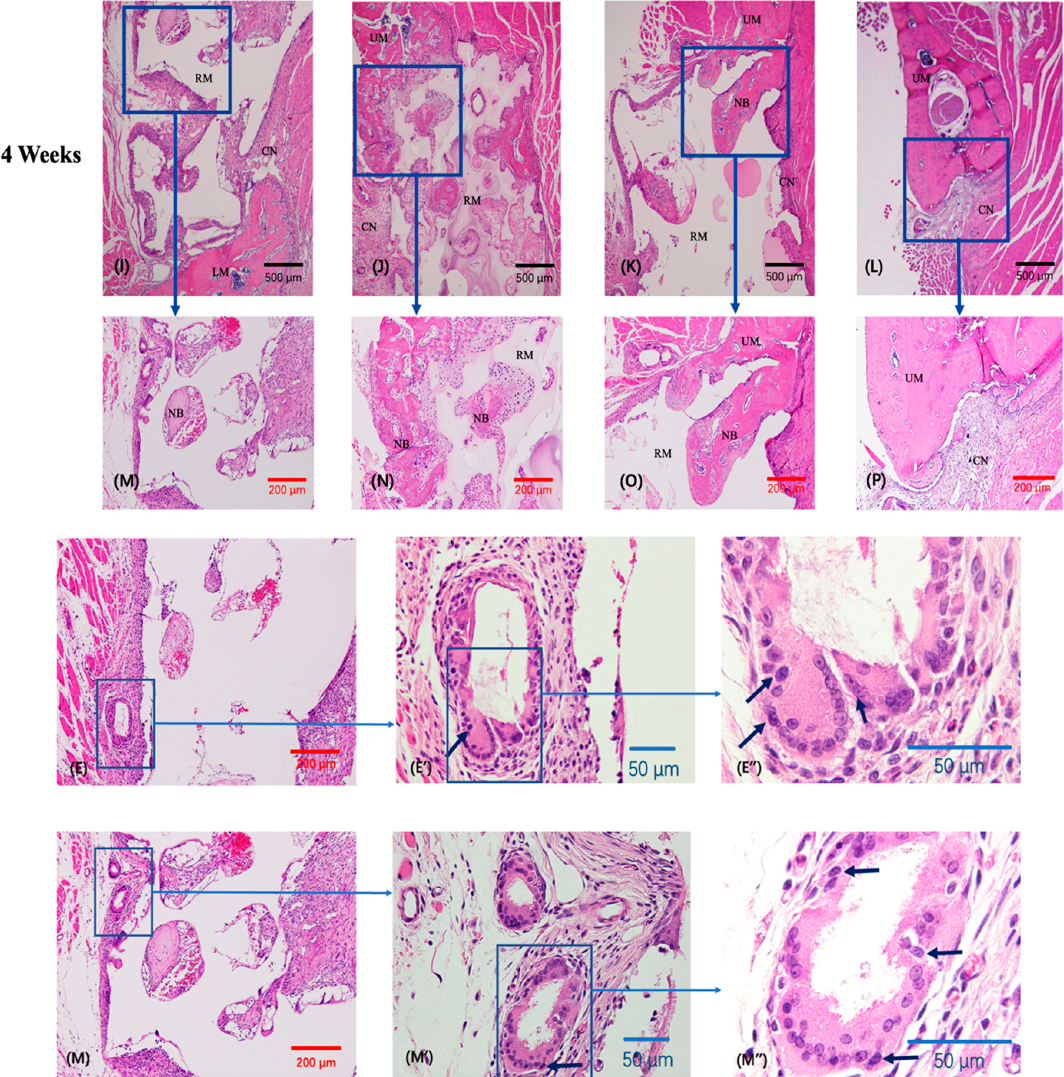
Figure 5. Hematoxylin and eosin staining of specimens in the β -TCP/PDLLA ( n = 3), β -TCP ( n = 3), PDLLA ( n = 3), and sham ( n = 3) groups. ( A – H , E’ , E’’ ) Sections at 2 weeks after mandibular defect surgery. ( I – P , M’ , M’’ ) Sections at 4 weeks after mandibular defect surgery. UM, upper mandible; LM, lower mandible; RM, residual material; NB, newly formed bone; CN, connective tissue. All slices are shown at ×4, ×10 and ×40 magnification. Scale bars: 500 μ m (black), 200 μ m (red), and 50 μ m (blue). The black arrows indicate the multinucleate cells observed in the H&E slices, adjacent to the scattered biocomposites.